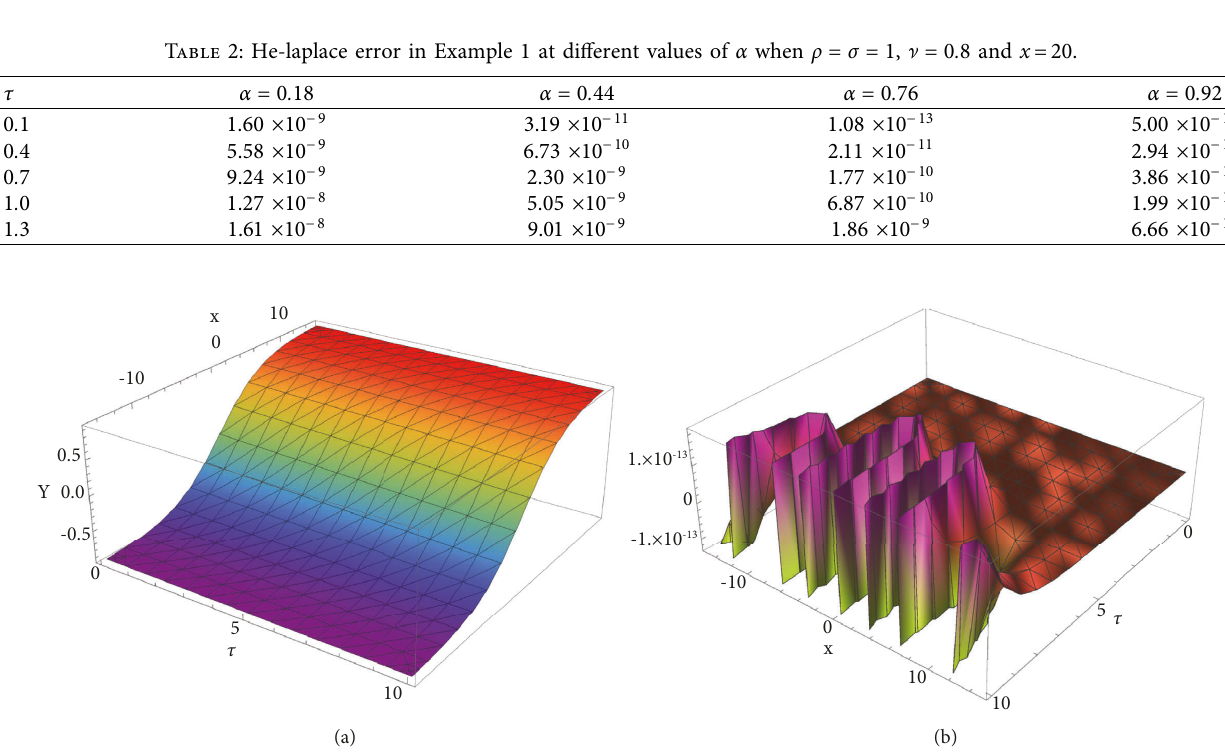
Figure 1: 3D plot of solution and error in Example 1, when α � 1, ρ � σ � 1 and ] � 0.1. (a) Solution. (b) Error.